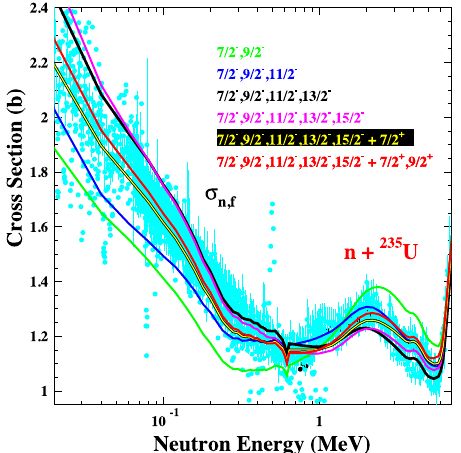
Fig. 7. Fission cross-section obtained increasing the number of coupled levels in the CC approach for neutron induced reaction on 235